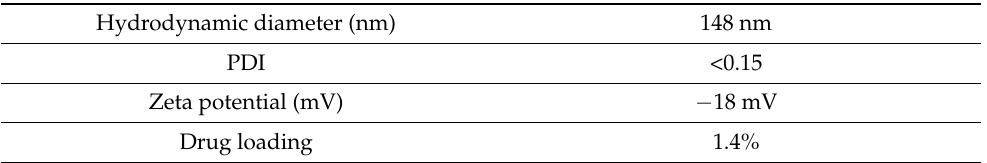
Table 1. PTX-NPs physicochemical characterization. To determine the hydrodynamic diameter (nm), PDI, surface charge (mV) and drug loading. N = 10 replicates.